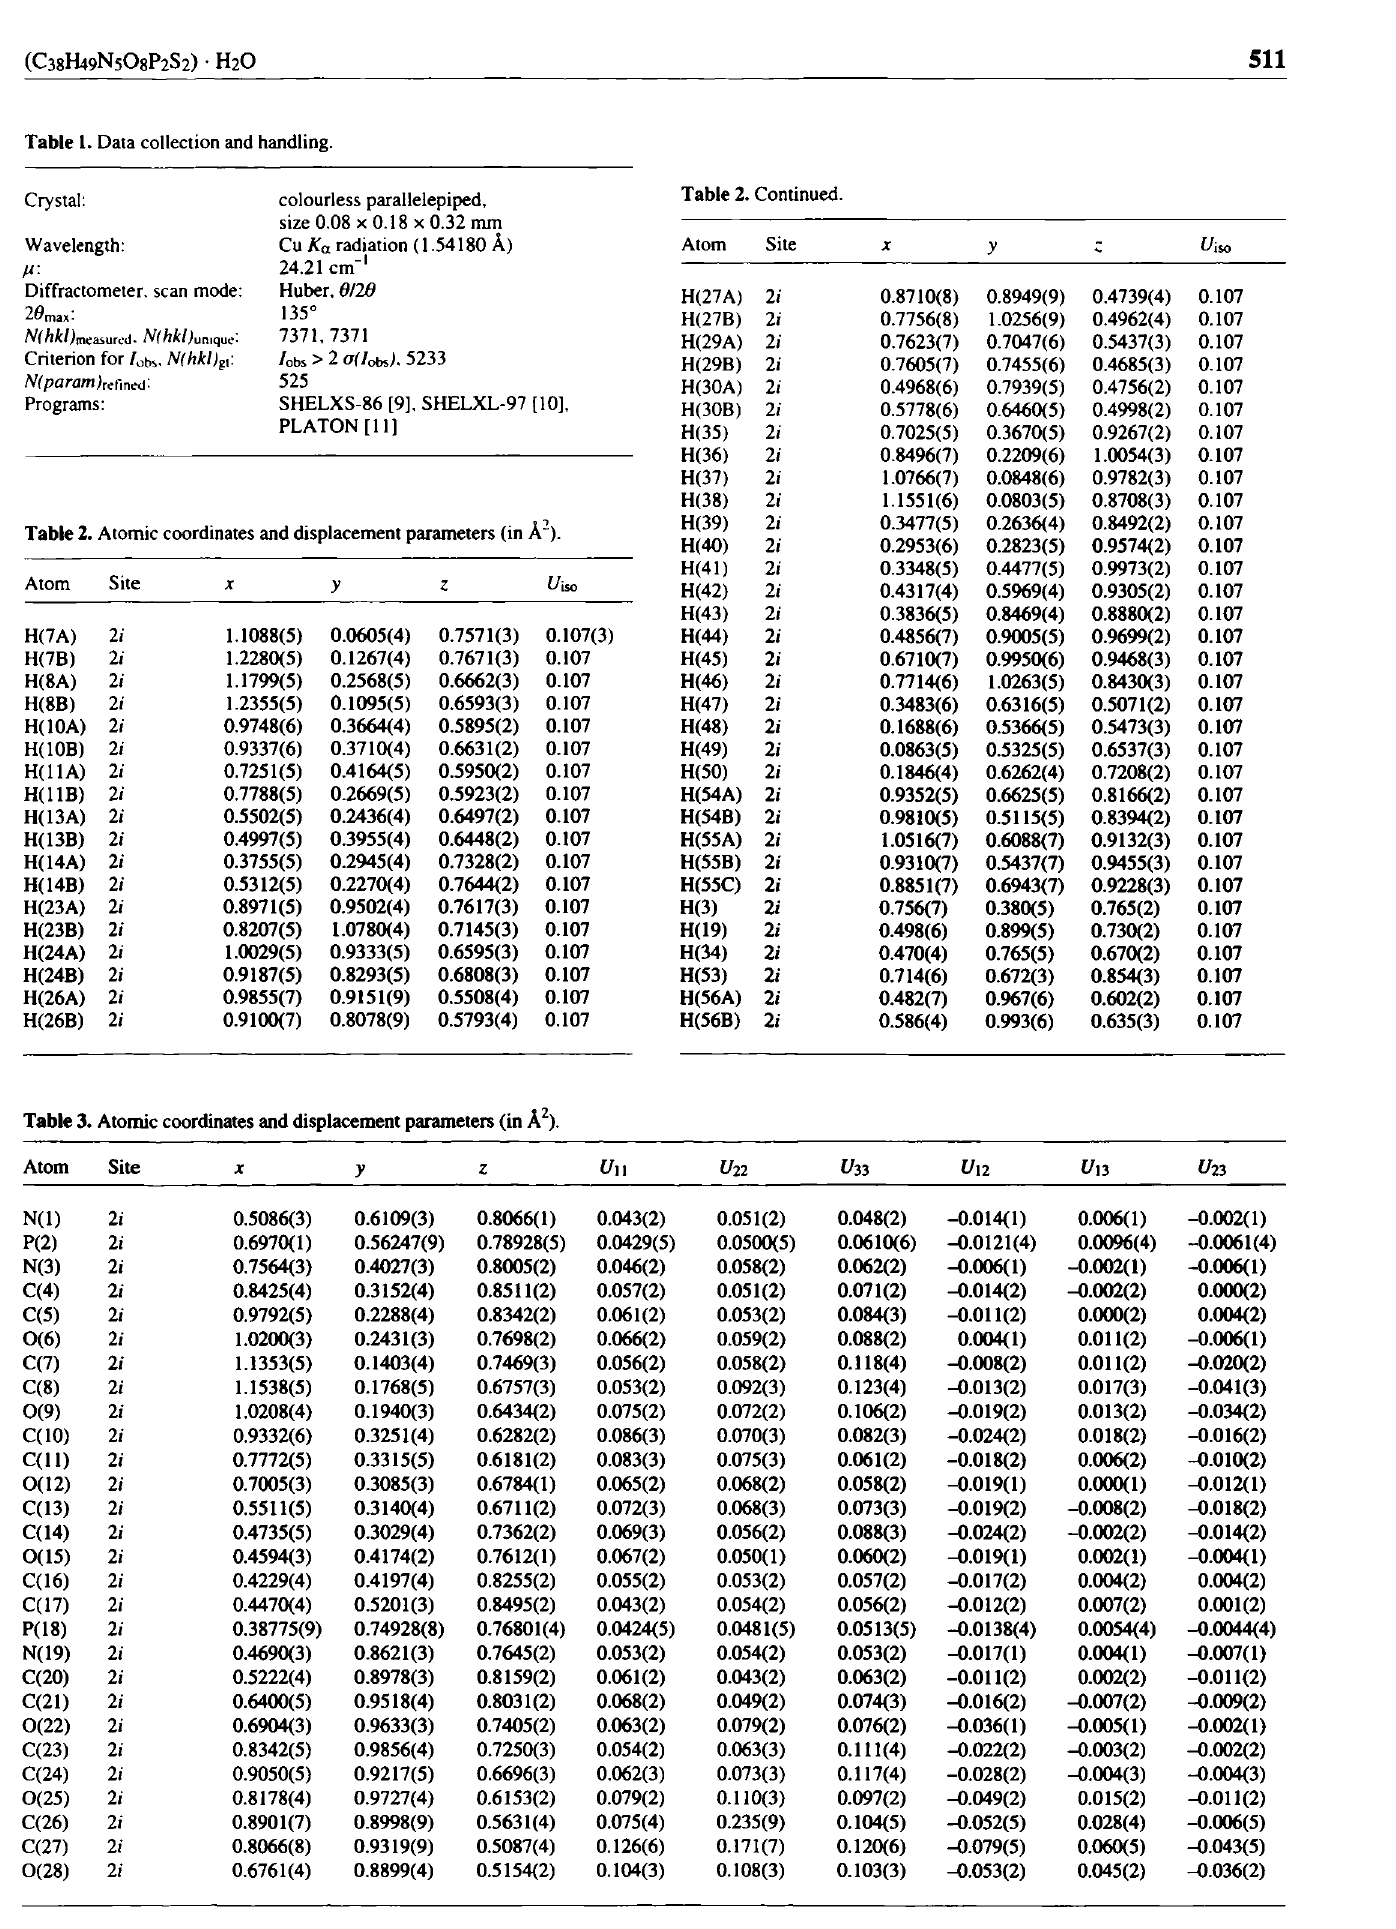
Table 1. Data collection and handling.